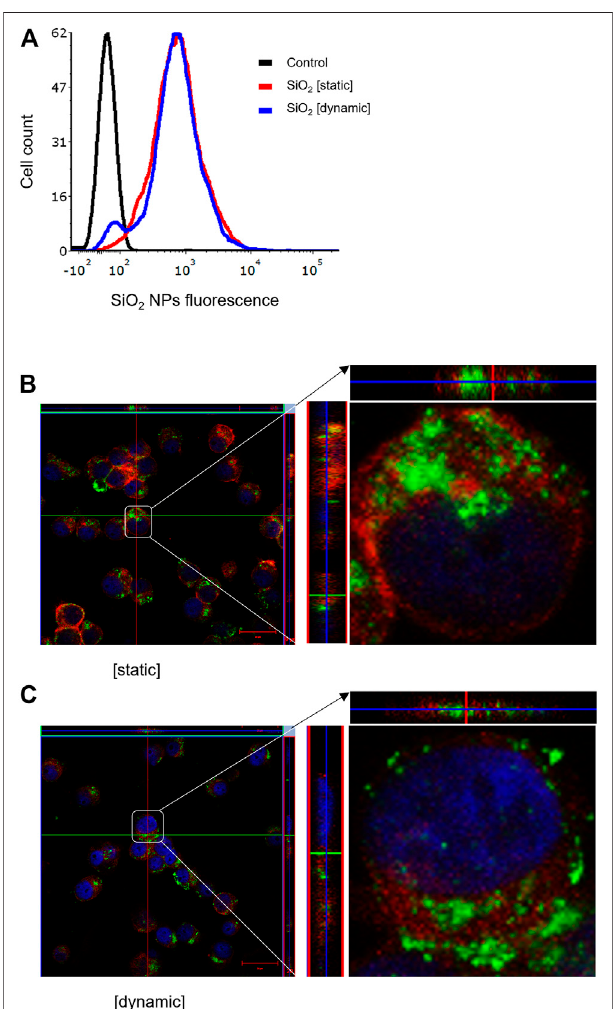
FIGURE 3 | Cellular uptake of fl uorescent SiO 2 NPs (10 μ g/ml) under static and dynamic exposure conditions. (A) Cellular uptake of SiO 2 NPs determinedusing fl owcytometryafter 2 hofexposure ofBEAS-2B cells (B,C) ConfocalmicroscopyofcellsexposedforSiO 2 NPsafter2 hunderstatic and dynamic exposures, respectively. The z-stack imaging con fi rmed the intracellularpresence oftheNPs. Cellsare counterstained using phalloidin red and DAPI (blue) to visualize the actin cytoskeleton and cell nucleus.